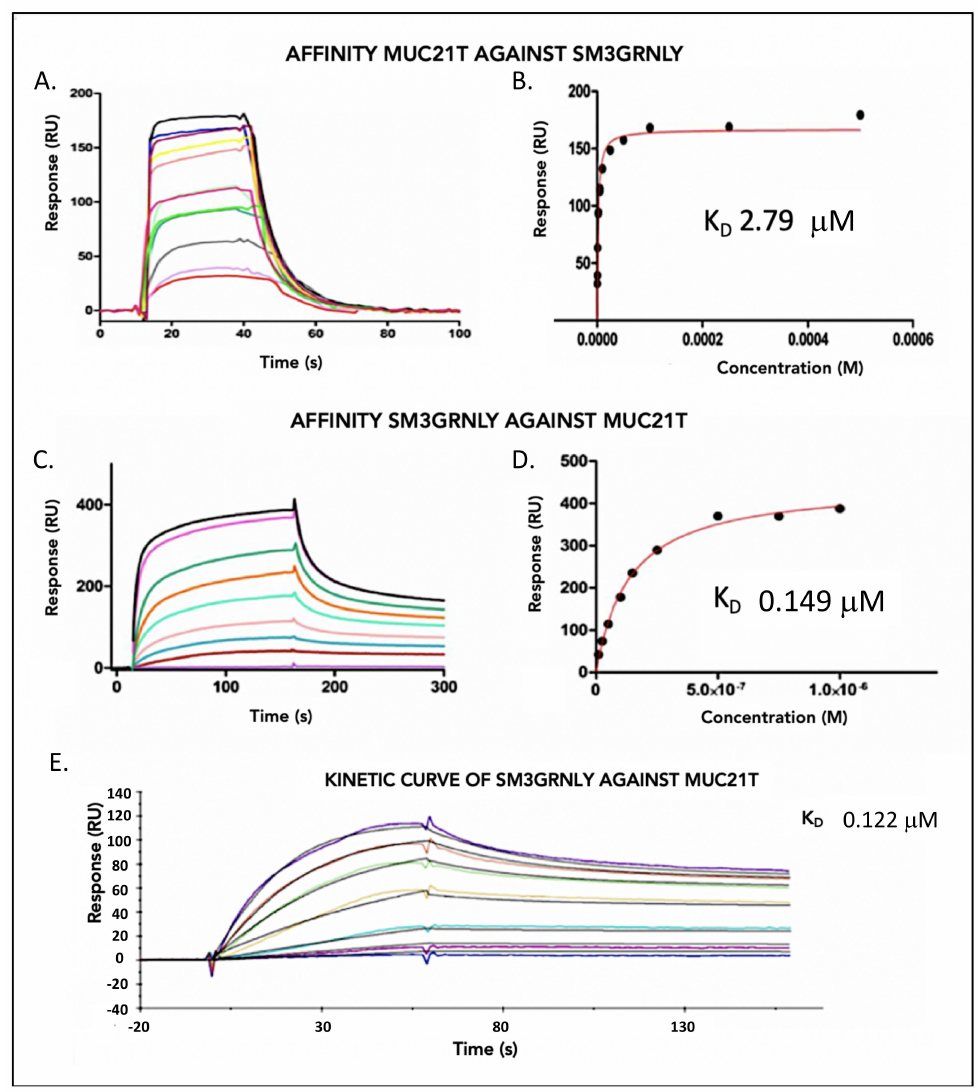
Figure 2. SM3GRNLY-MUC1-Tn SPR Affinity Assays. ( A , B ) 5700 RUs of SM3GRNLY were immobi- lized on the biosensor. The response was measured at different concentrations of the antigen, ranging from 0.05 µ M to 500 µ M. ( C , D ) 390 RUs of MUC1-Tn were immobilized and different concentrations of SM3GRNLY were studied. ( E ) K D calculation using kinetic adjustment. Colored lines correspond to the determinations with the different concentrations used in the